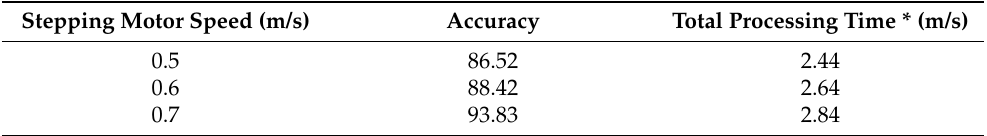
Table 9. Scenario 2: Performance evaluation of the overall system according to the control of stepping motor.